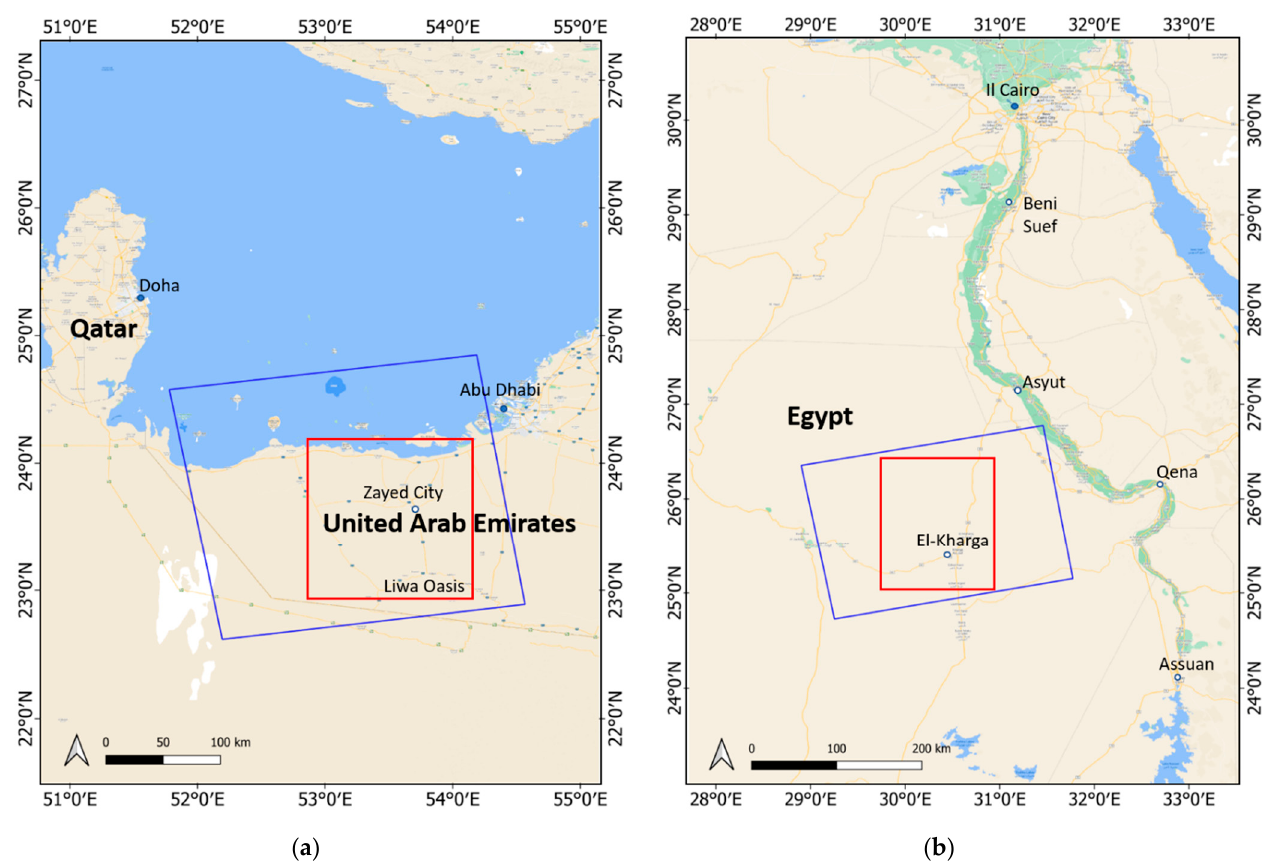
Figure 1. Regions of interest (red boxes) and Sentinel-1 frames (blue boxes) selected for the United Arab Emirates (UAE) ( a ) and Egypt ( b ) use cases. Basemap © Google Copyright.